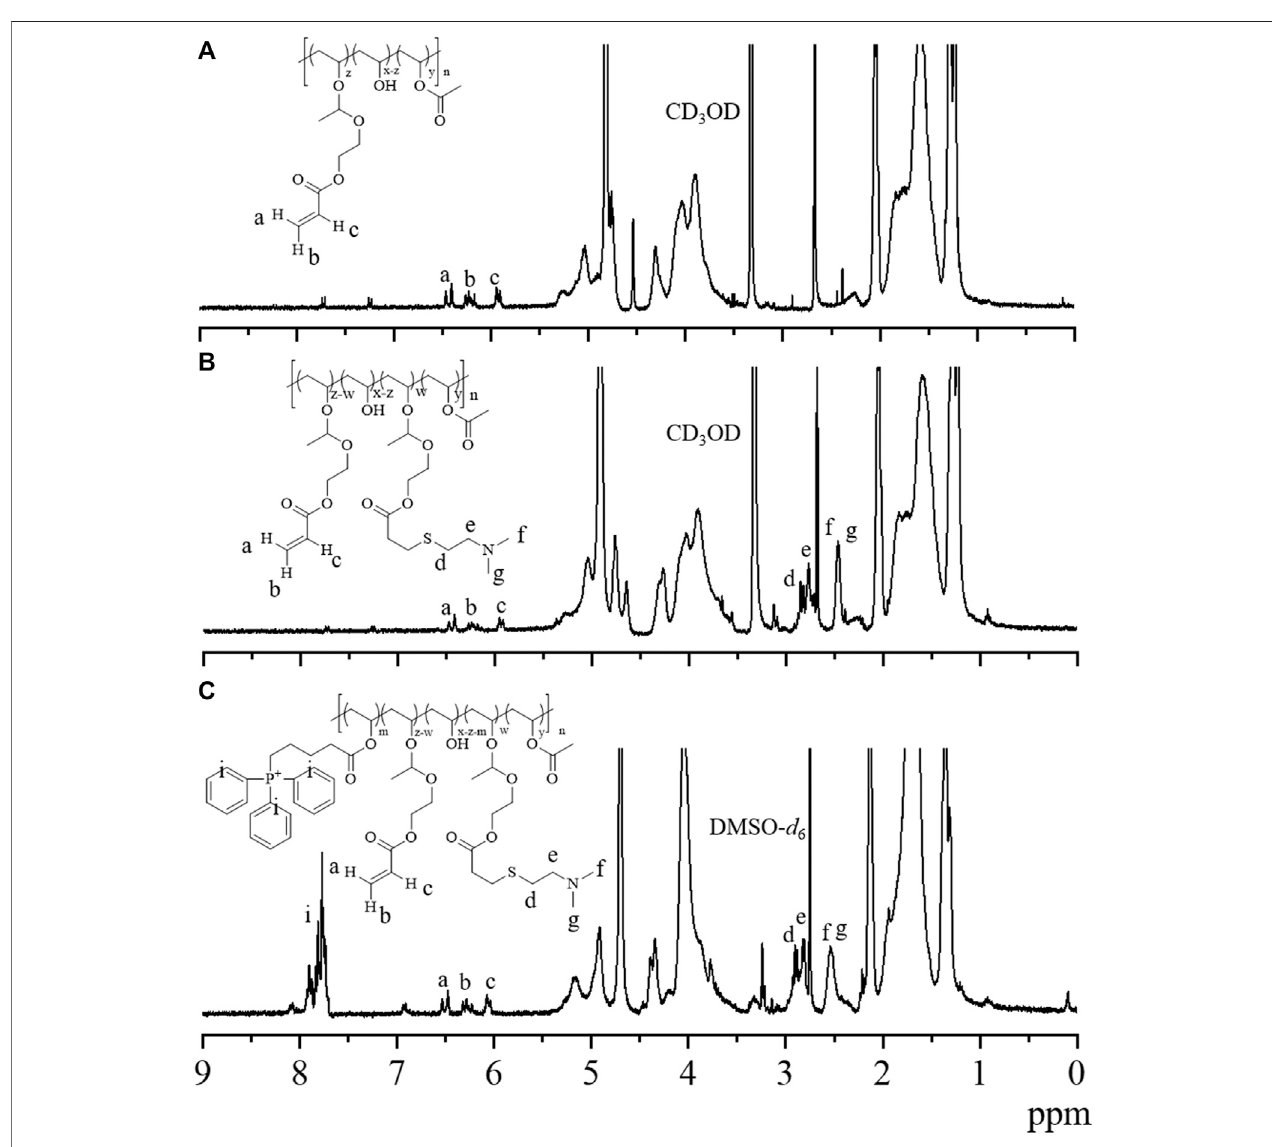
FIGURE 1 | 1 H NMR spectra of (A) PVA- g -VEA (300 MHz, CD 3 OD), (B) PVA- g -VEA-DMA (300 MHz, CD 3 OD), and (C) PVA- g -VEA-DMA/TPP (300 MHz, DMSO-